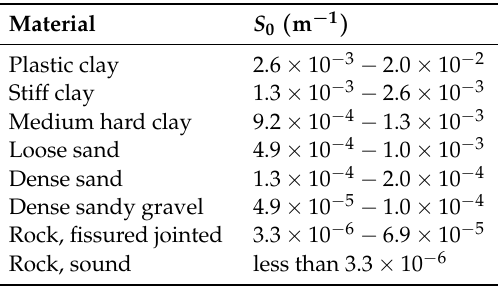
Table 1. Specific storage ( S 0 ) values for different materials